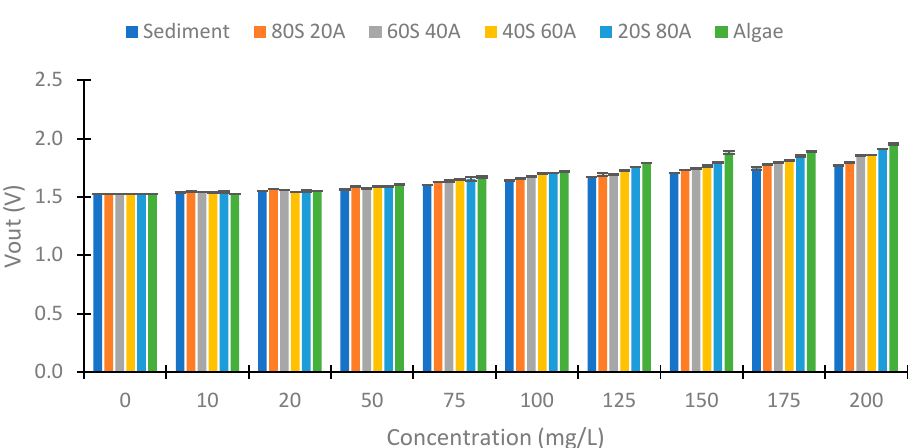
Figure 12. Vout with the use of red light at voltage divider LDR at 180°.